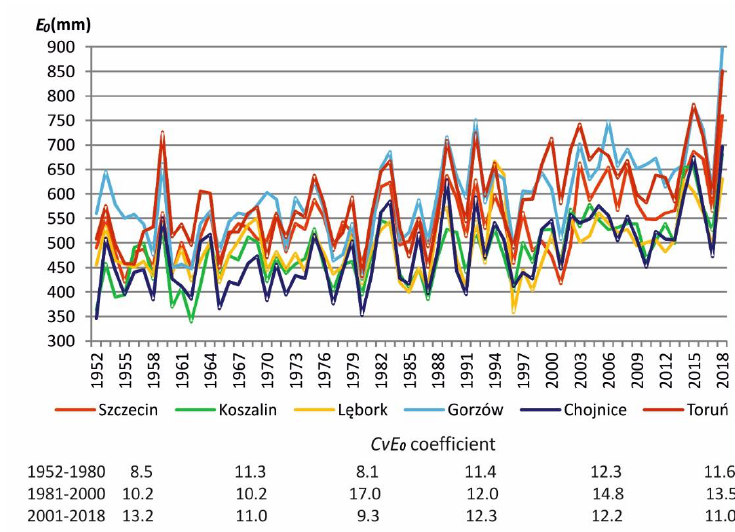
Figure 4. Long-term changes in annual sums of evaporation ( E 0 , mm) and coefficient of E 0 variation ( CvE 0 , %) in the examined stations (1952–2018) (calculated based on t and f and data obtained from the Polish Institute of Meteorology and Water Management—National Research Institute [43]).